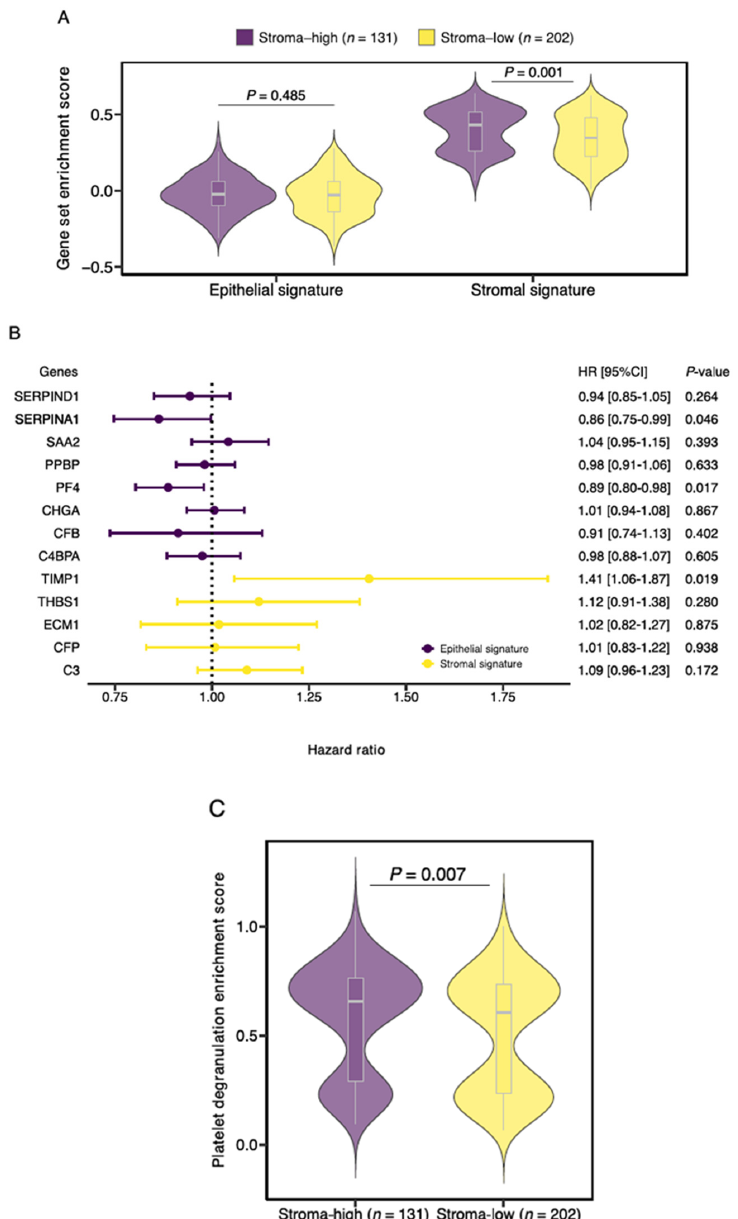
Figure 5. Characterization of the Stromal Liquid Biopsy (SLB) panel genes. ( A ) Gene enrichment scores of the newly defined stromal and epithelial signatures for stroma-high and stroma-low tumors. ( B ) Forest plot of univariate Cox regression analyses for the overall survival of the 13 SLB genes included in this study. ( C ) Platelet degranulation pathway enrichment score for stroma-high and stroma-low tumors. HR, hazard ratio.